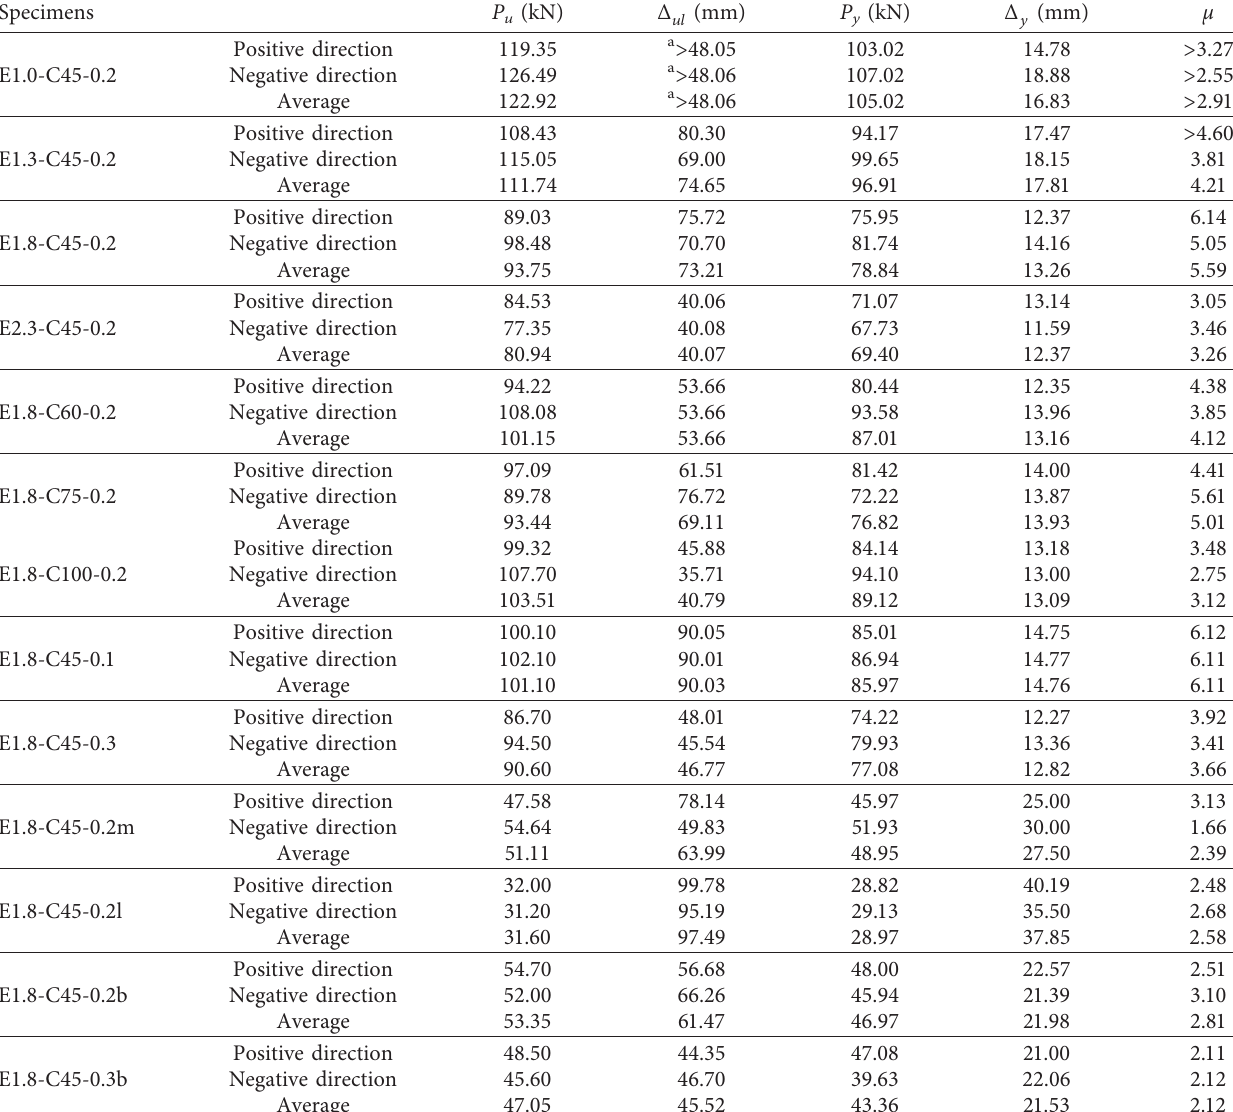
Table 4: Load bearing capacity and ductility of test